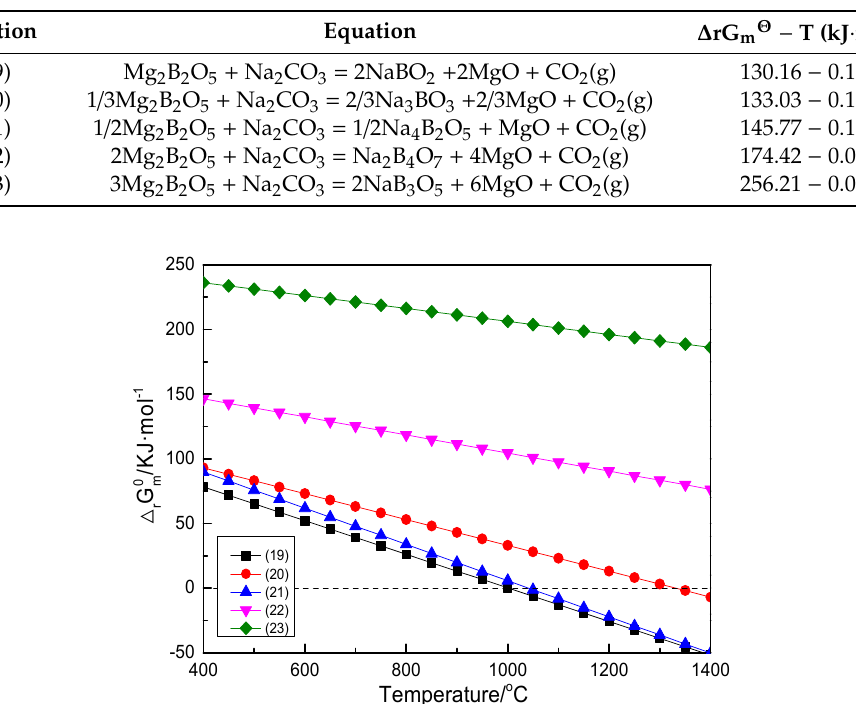
Figure 5. Plots of Gibbs free energy against the temperature of Na 2 CO 3 ‐ Mg 2 B 2 O